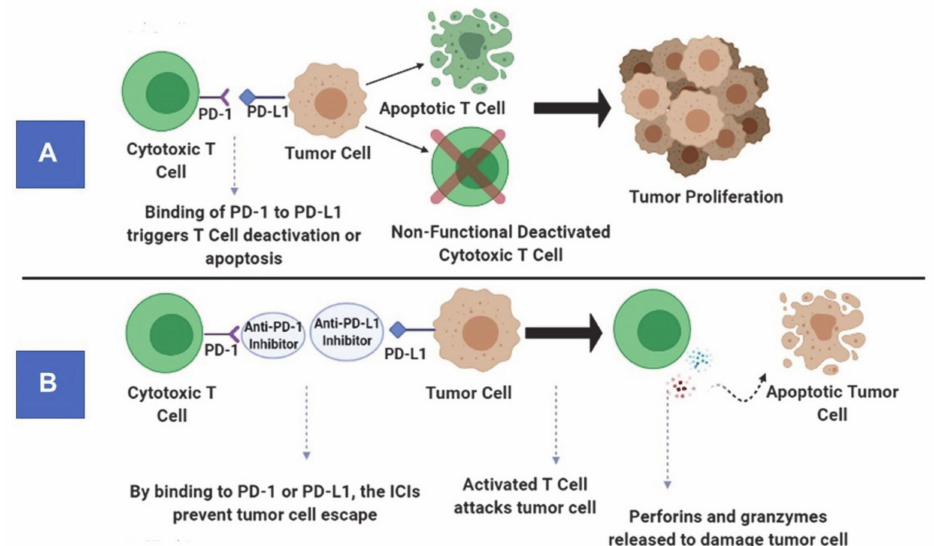
Figure 2. Principle of immune checkpoint pathways under physiological conditions ( A ). Mechanism of action of anti- programmed cell death protein-1 (PD1) antibody (an immune checkpoint inhibitor) ( B